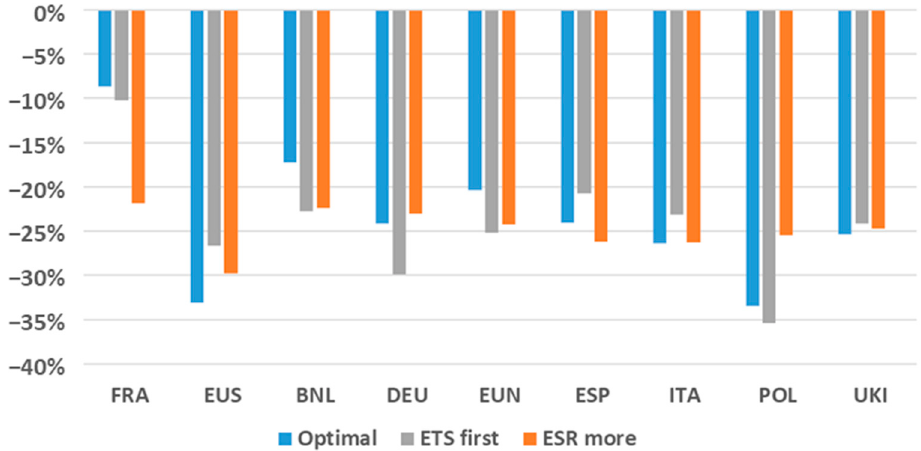
Figure A3. Deviation of EU27 + UK regional CO 2 emissions in 2030 relative to the reference scenario.